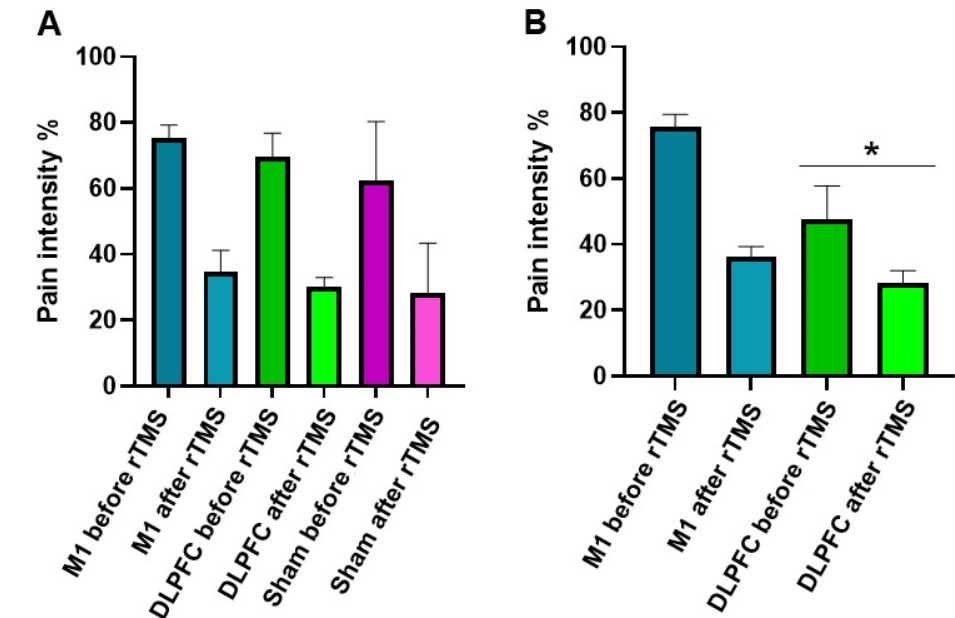
Figure 4. rTMS effects on pain intensity between the groups on the 4th week ( A ) and 36th week ( B ). The y-axis indicates the mean pain intensity expressed as a percentage (%). The x-axis depicts the time points (in weeks) of conducted measurements. The * symbols indicate significant group differences (Bonferroni corrected, two-tailed, paired t -test, p ≤ 0.05). Error bars depict the standard error of mean (SEM). For the AUC, there were no significant group differences (all p ≥ 0.05) from baseline until the end of the daily (5th day) experimental session (Figure 5B). In contrast, the AUC from the 6th to the 13th experimental session was significantly smaller in the DLPFC-group compared to the M1-group ( p = 0.007) (Figure 5B).